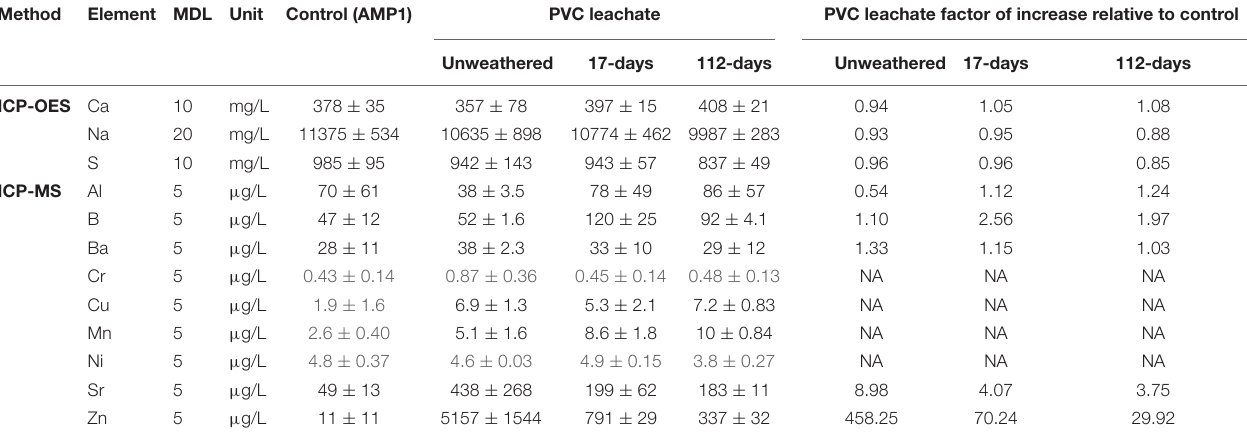
Values reported here are means ± standard errors; where mean concentrations were lower than the method detection limit, results are shown in gray font. Factors of increase were not calculated where measurements were below the accurate detection limit for control media. Si, As Cd, Mo, Pb, Sn, V concentrations were under the detection limit for both leachate and control (so values not